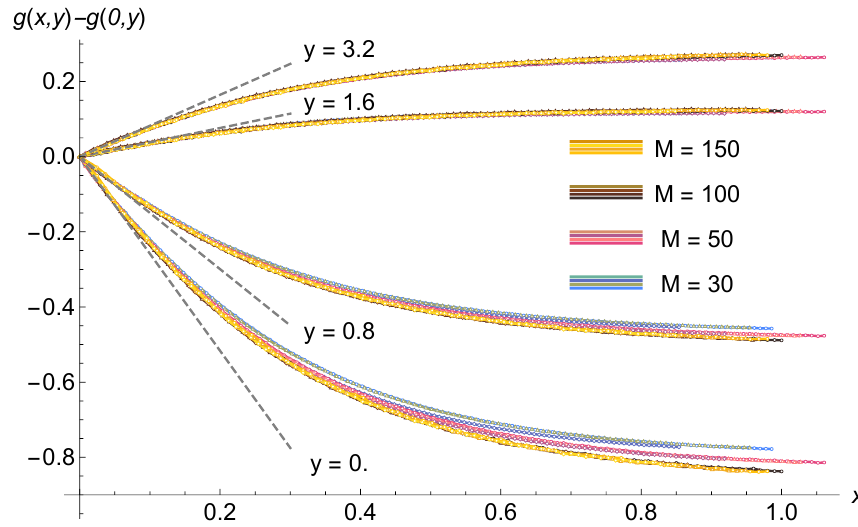
Figure 9: Plot of the same data as in figure 6, subtracted as explained in figure 8. Straight dashed lines have the same significance as in figure 8.